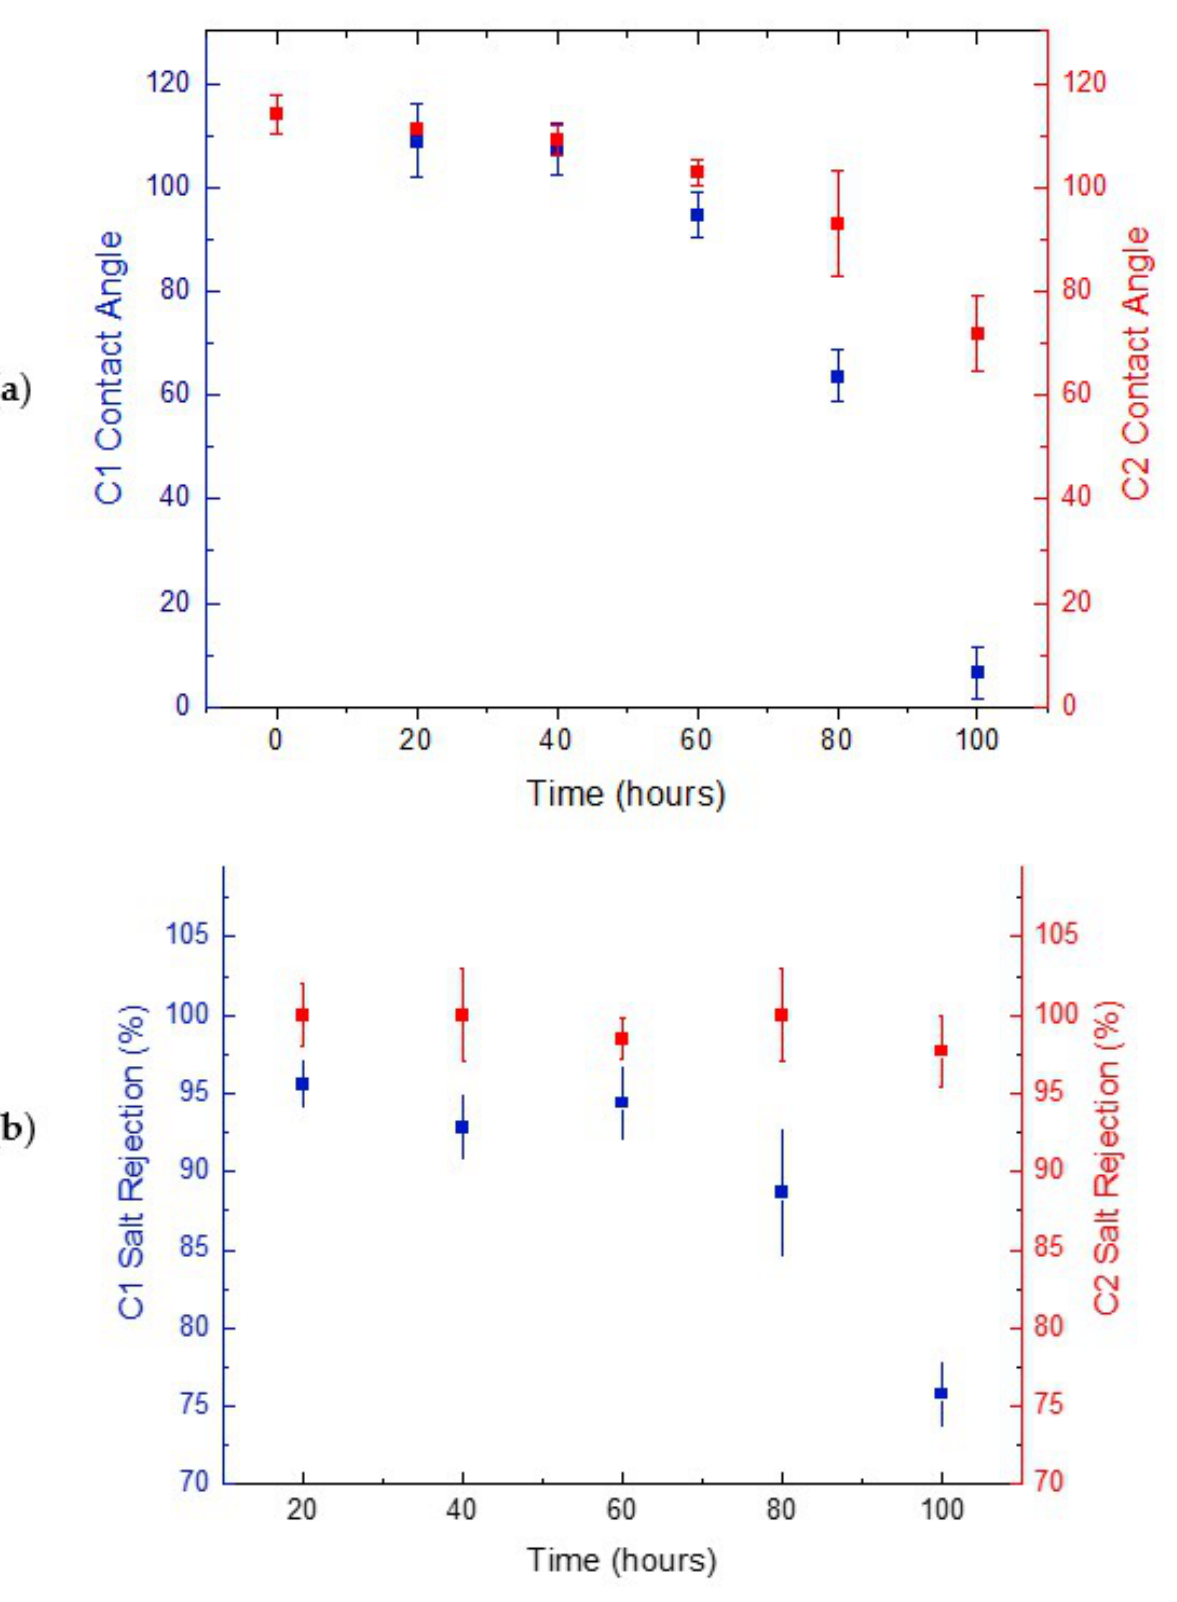
Figure 6. Contact angles ( a ) and salt rejections ( b ) of tested PE membranes during longtime DCMD operation at pilot scale.